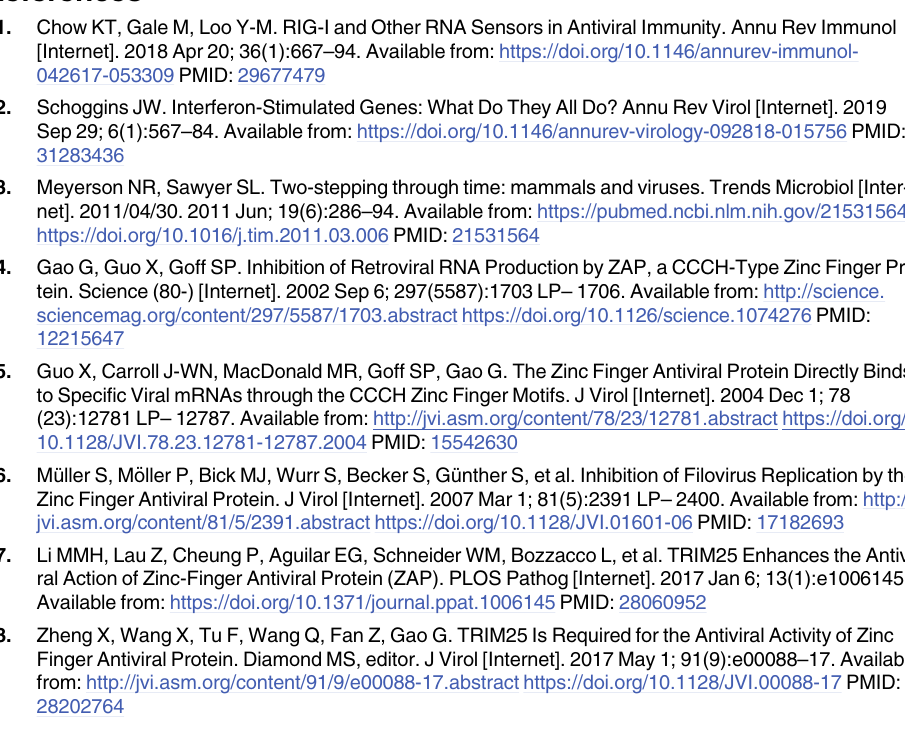
S8 Fig. Comparison of the RNA-binding domains of human, chicken and alligator ZAP. (A) Protein sequence alignment of human, chicken and alligator N-terminal region. Zinc fin- gers are highlighted in solid line boxes while putative helices (1) and (2) are highlighted in dashed line boxes. Cov, percentage of sequence coverage; Pid, percentage of protein identity.